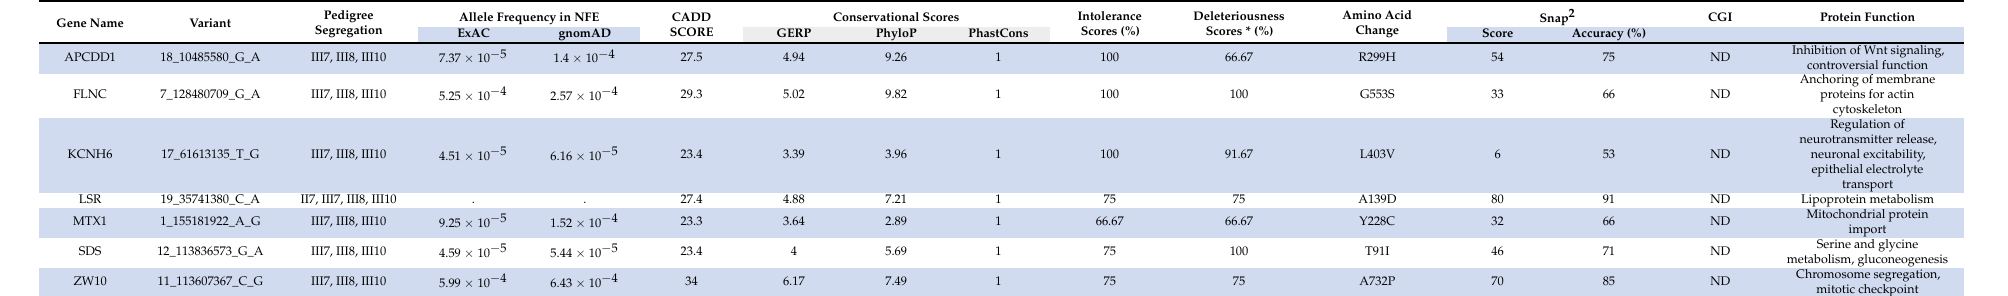
* Following predictions given by deleteriousness scores were considered as favorable in our analysis: SIFT—Damaging (D); Polyphen2_HumDiv, Polyphen2_HumVar—Probably damaging (D) and Possibly damaging (P); LRT—Deleterious (D); MutationTaster—Disease causing (D) and disease causing automatic (A); MutationAssesor—High (H) and medium (M); FATHMM—Damaging (D); MetaSVM—Damaging (D); MetaLR—Damaging (D); Reliability Index ≥ 5; VEST3 ≥ 0.5; PROVEAN—Damaging